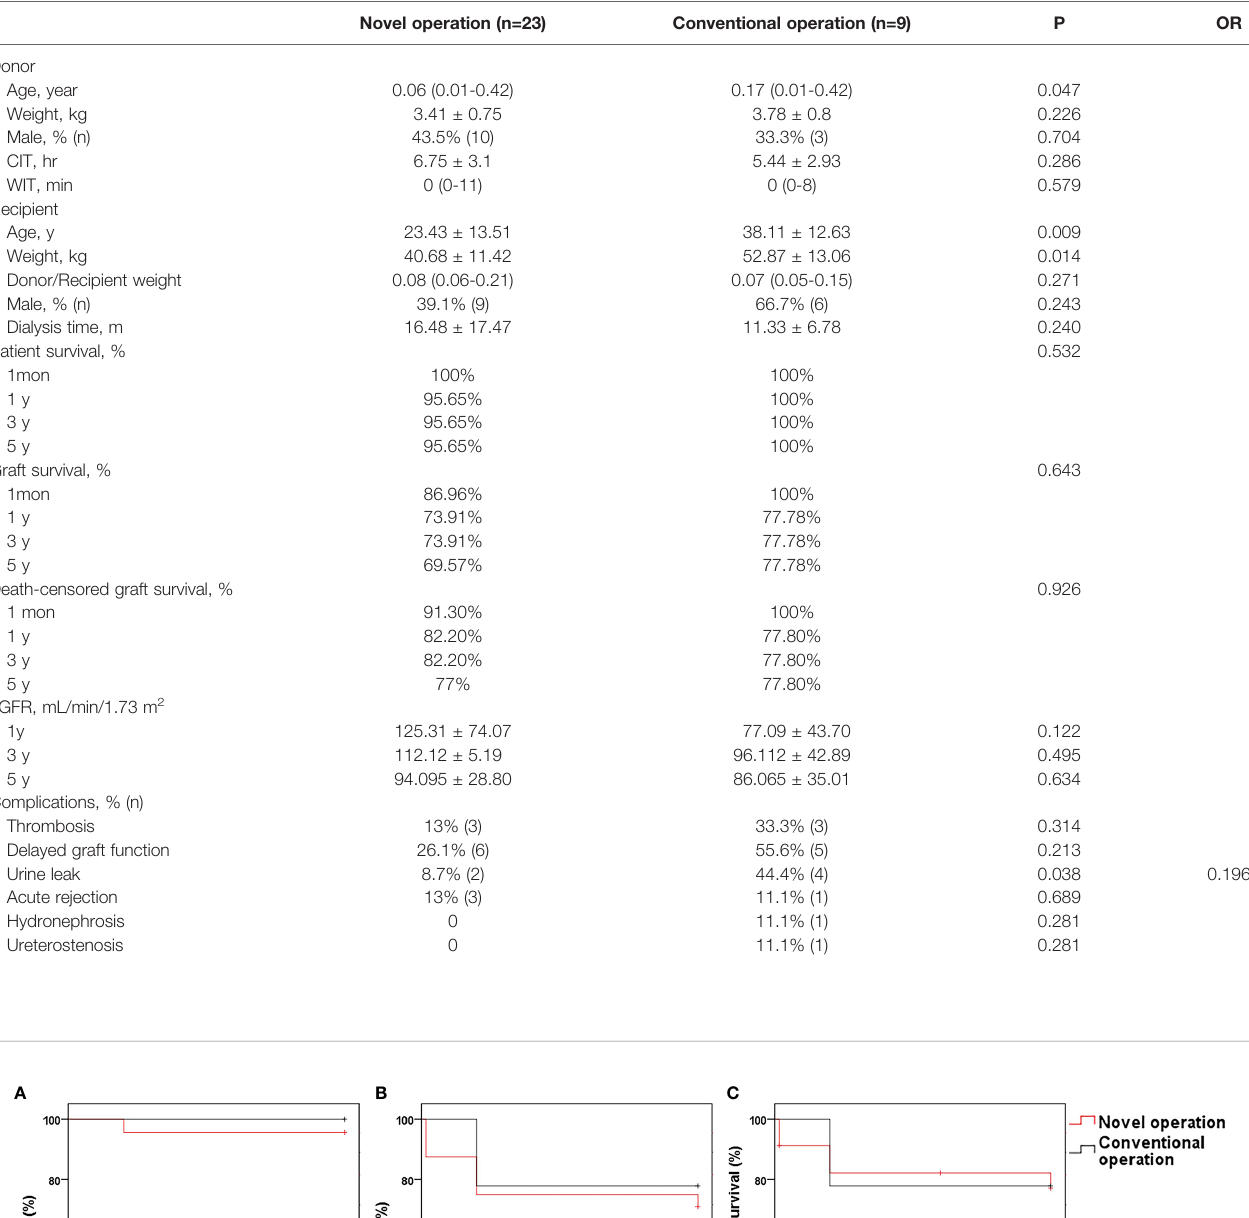
TABLE 5 | Subgroup comparison of kidney transplantation using grafts obtained from pediatric donors of extremely low body weight with different surgical